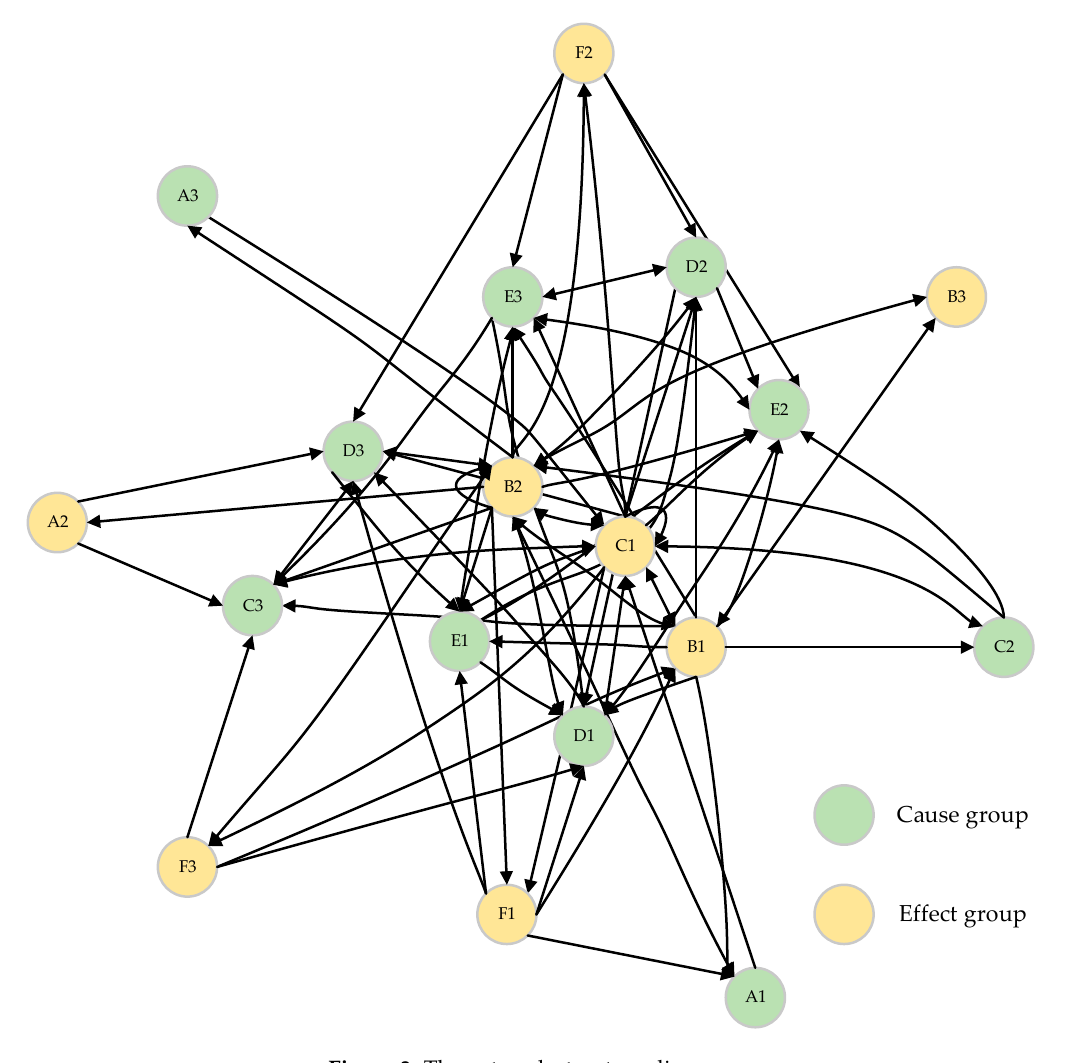
Figure 3. The network structure diagram. Table 4. The initial fuzzy direct relationship matrix . Table 5. Centrality degree and cause degree for